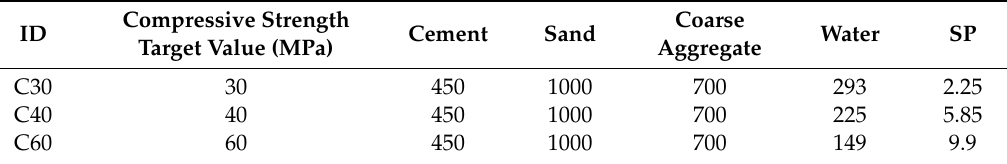
Table 3. Details of mixture proportions (kgf / m 3 ).